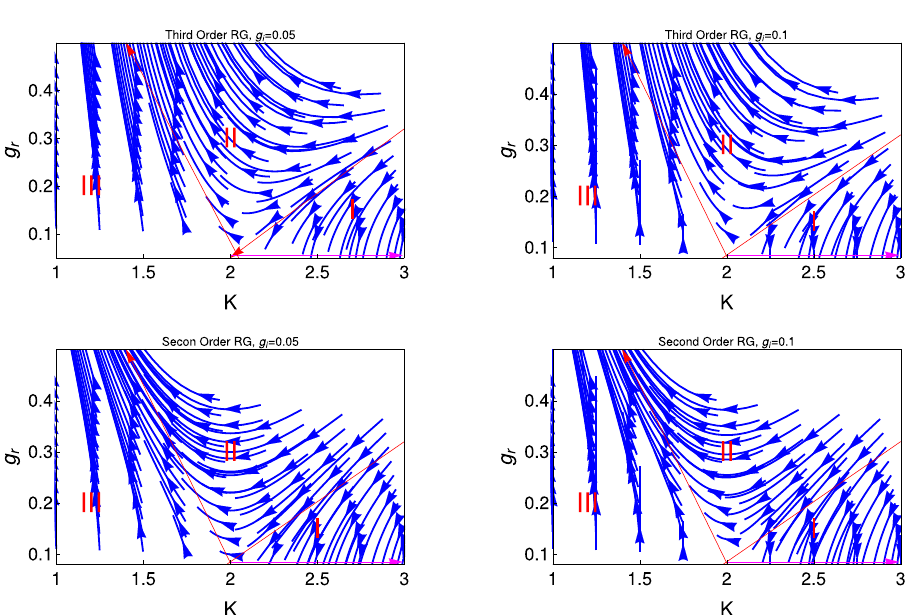
Figure 3. These figures show behaviour of RG flow lines, g r with K two different initial values g i ( 0 ) . The upper (Eq. 5) and lower (Eq. 4) panels are, respectively, for results of third and second order RG studies. We mark different regions of quantum phases by I, II, III and the separatrix by the red colour lines. The magenta colour line represent the fixed